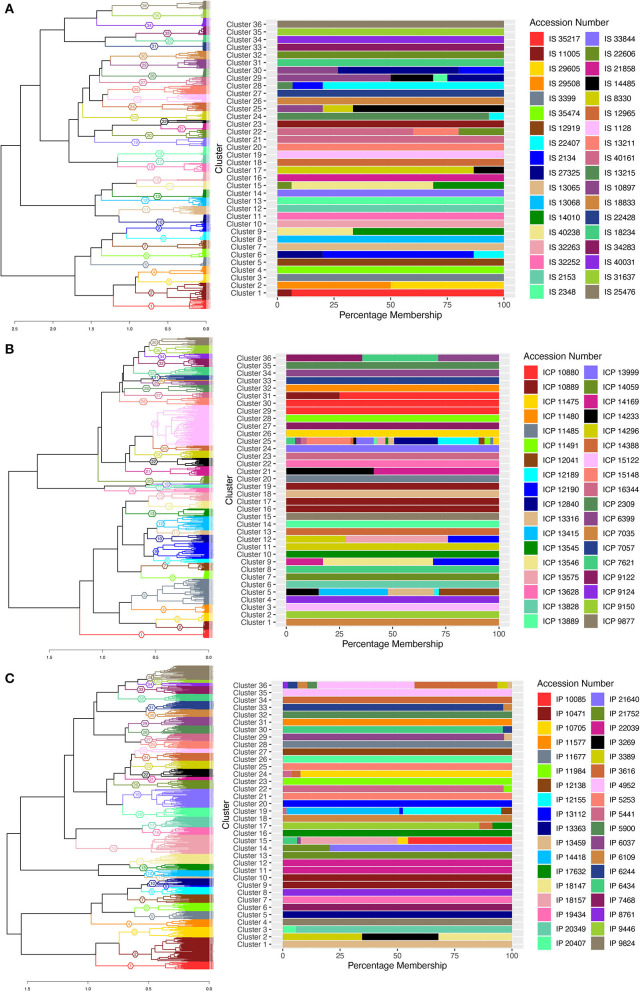
Cluster dendrogram of single plant genotypic distances estimated from DArTSeq- SNP data, using ward.D2 clustering algorithm, 36 clusters for sorghum, pigeonpea, and pearl millet, represented with colors and cluster numbers, with percentage membership of accessions into each cluster denoted by colors in the adjacent bar graph. (A) the cluster dendrogram of sorghum, (B) the cluster dendrogram of pigeonpea, and (C) the cluster dendrogram of pearl millet.